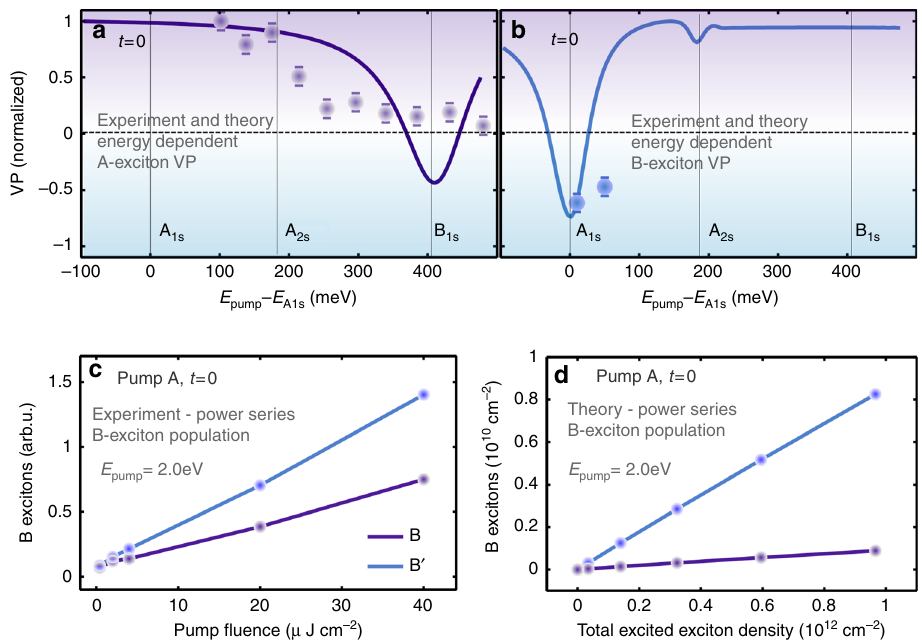
(cid:6) (cid:7) (cid:6) (cid:7) þ N K ′ = N K as a function of excitation energy in n n